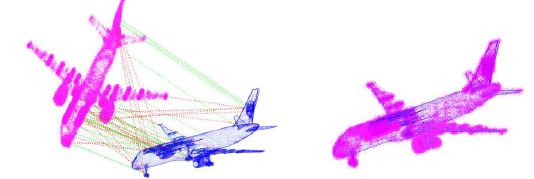
Figure 3: Primitive registration problem for the Aeroplane-2 mesh model. Green and red lines represent inlier and outlier correspon- dences respectively